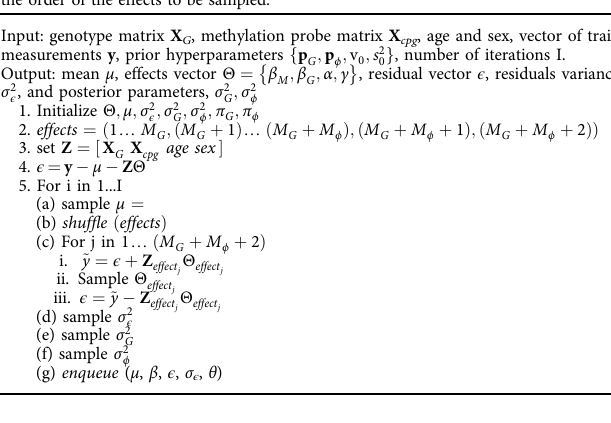
Algorithm 1 Algorithm for sampling over the posterior distribution p μ ; β ; ϵ ; σ ϵ ; θ ð Þ , each sample ( μ , β , ϵ , σ ϵ , θ ) is stored in a synchronized queue for a consumer thread to store in disk. X the order of the effects to be